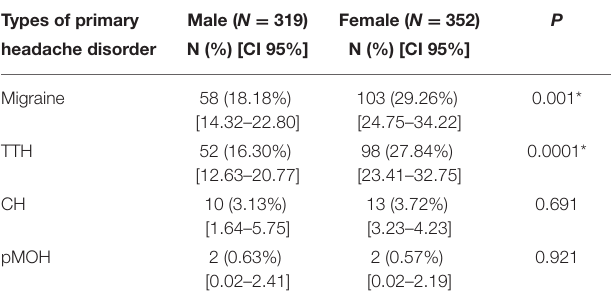
TABLE 7 | One-year prevalence of Types of Primary headache disorders stratified by gender in Middle school students ( N = 671). Types of primary Male ( N =